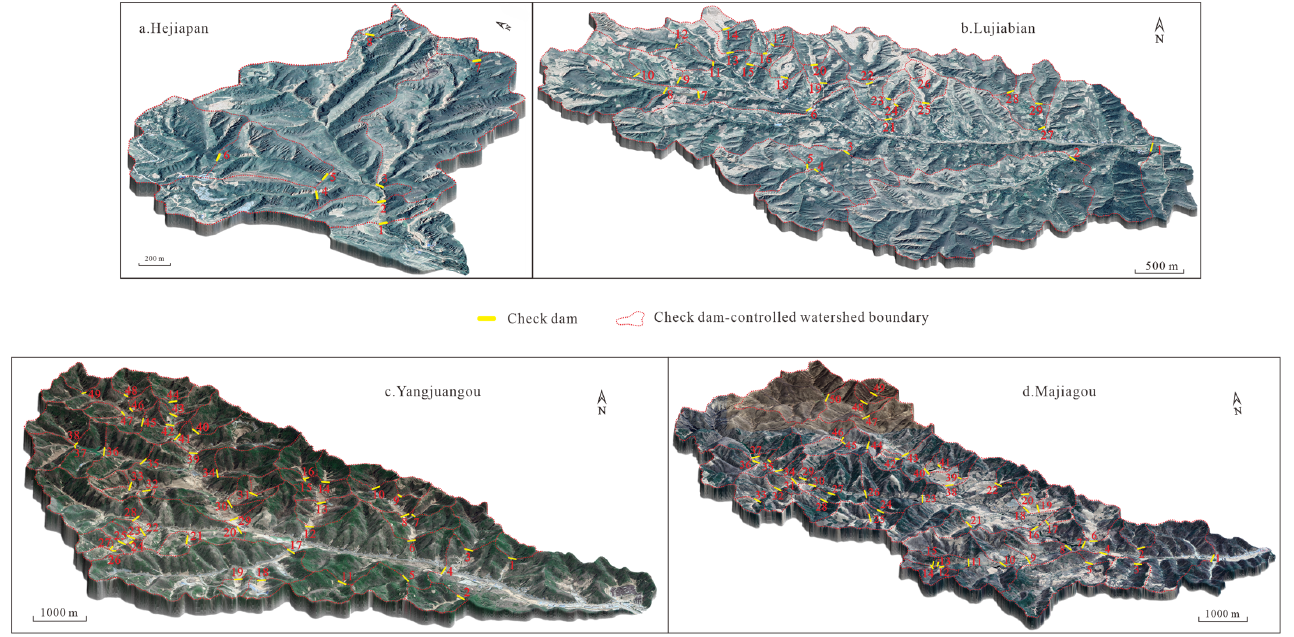
Figure 3. Distribution of check dams in four typical watersheds.